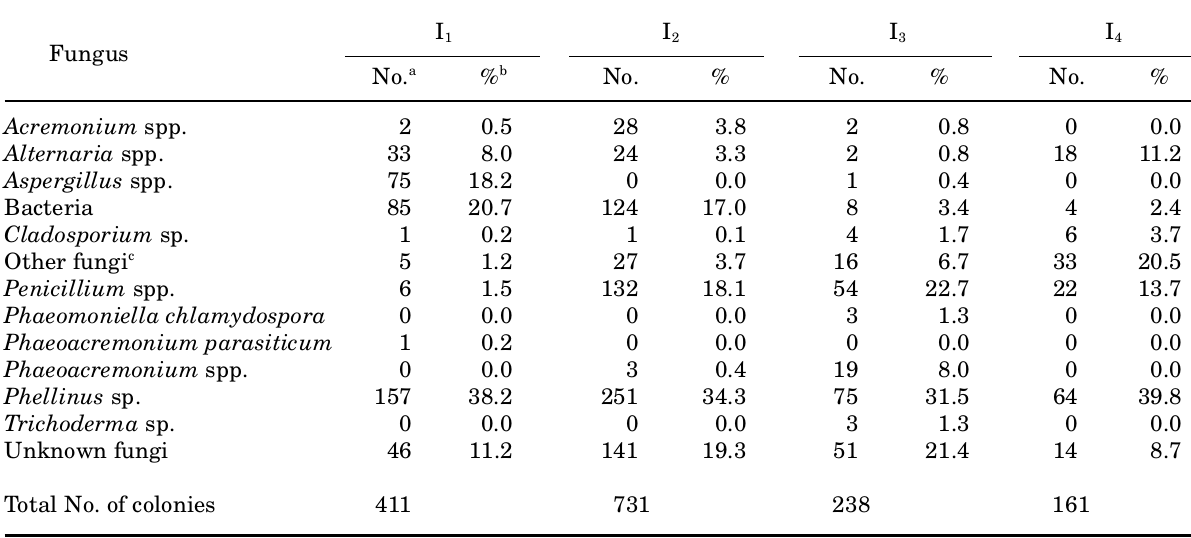
Table 2. Mycroflora isolated from discoloured wood in 4 vines (I 1514) and frequency of isolation (number of colonies of each species).